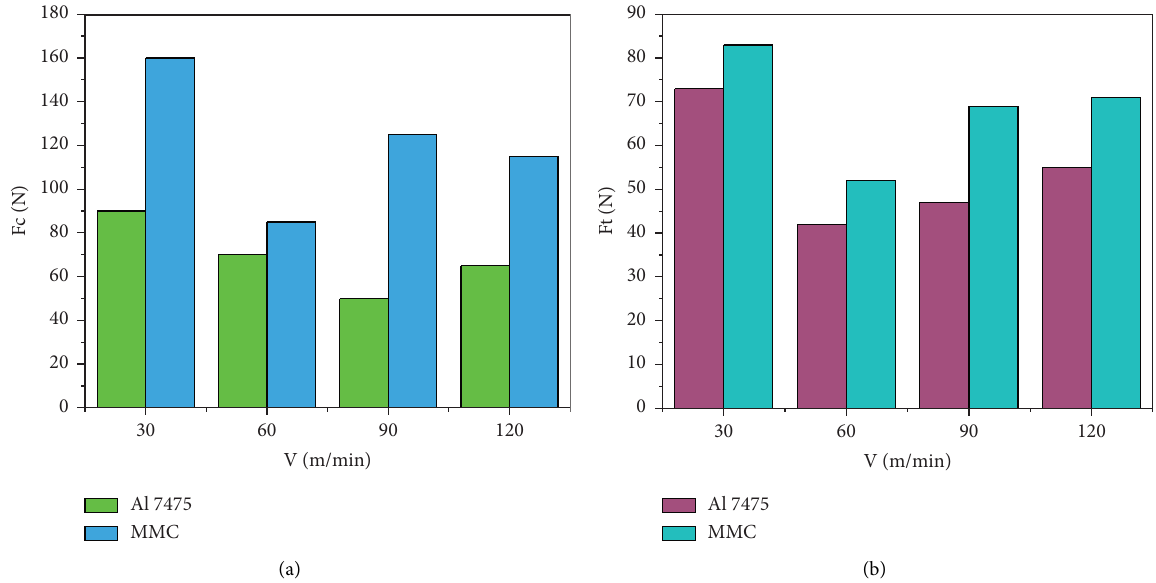
Figure 2: Comparison of (a) cutting force and (b) thrust force with speed (at f � 60 mm/min and a